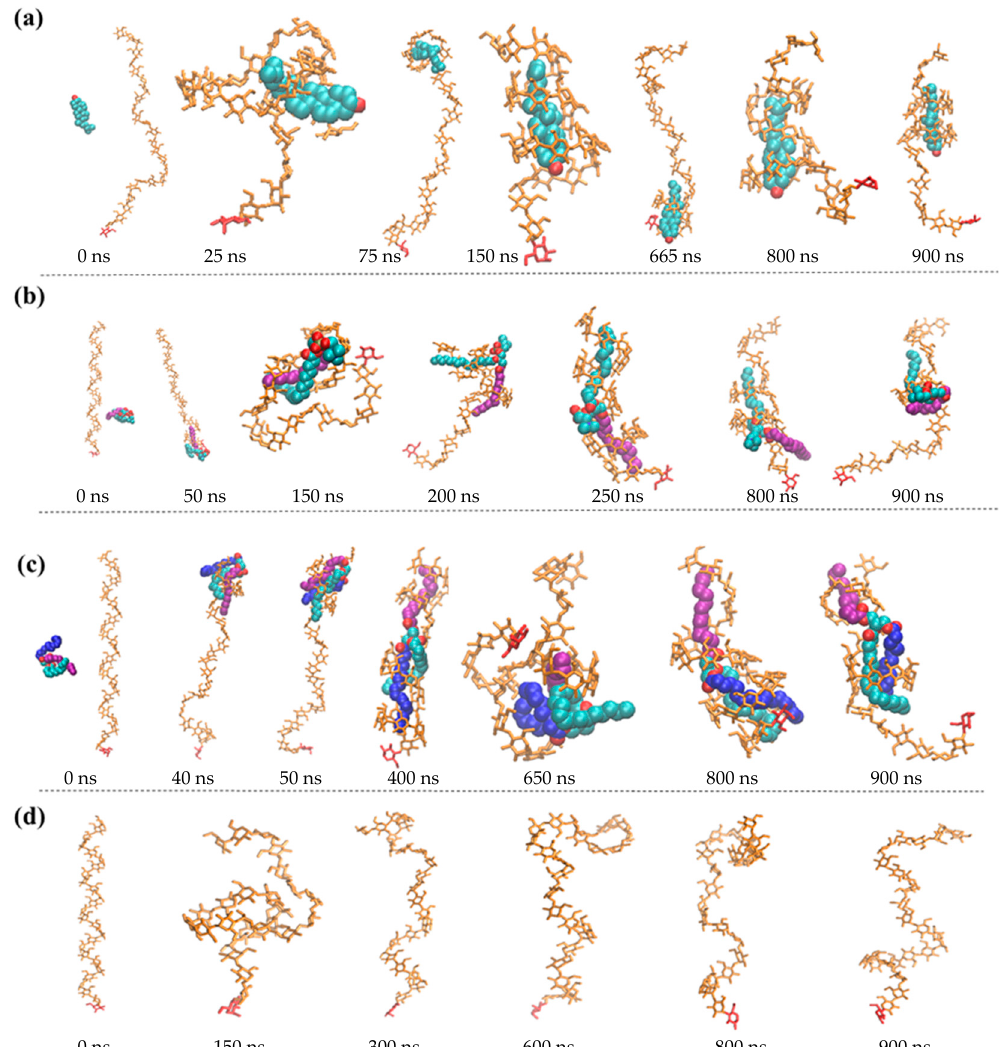
Figure 2. Snapshots of one-amylose and one-amylose-lipid complexes at various times (0–900 ns): amylose-cholesterol complex (( a ) oxygen atom of cholesterol is red), amylose-POPC complex (( b ) palmitoyl tail of POPC is in purple, oleoyl tail of POPC is in green), amylose-triglyceride complex (( c ) linoleoyl tail of triglyceride is in blue) and amylose (( d ) backbone is in orange and reducing end of 26-mer amylose is in red).